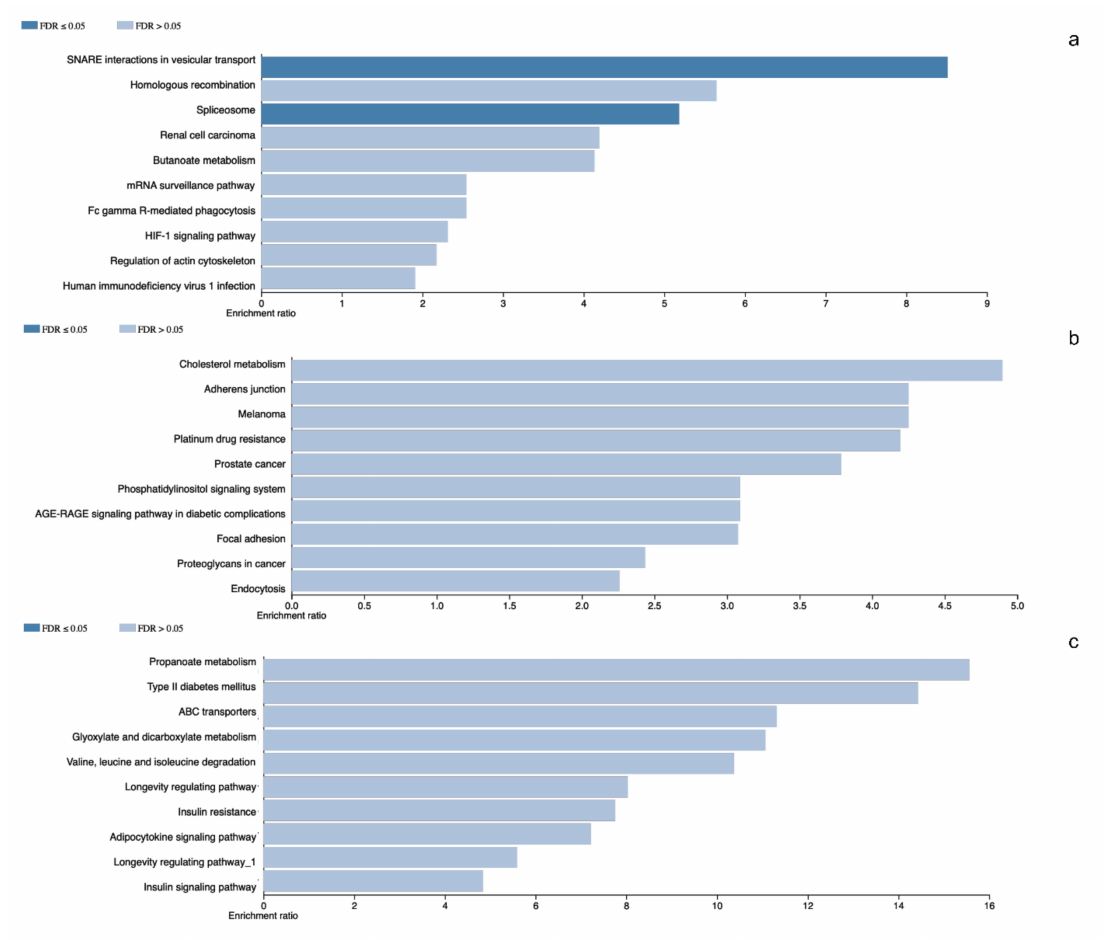
Figure 2. Venn diagram showing the common and distinctive proteins identified in the two pituitary tumor lineages and control gland.